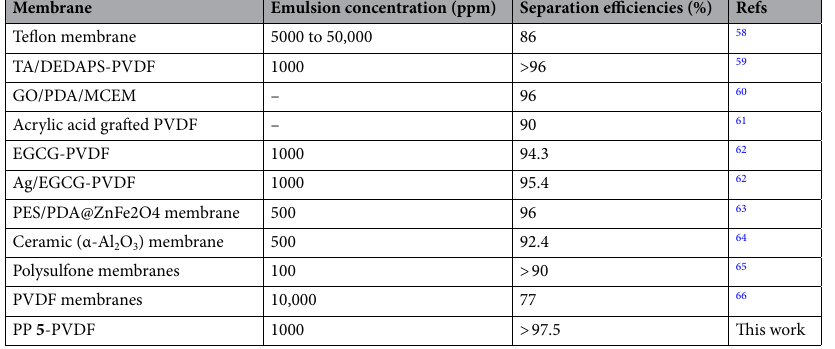
Table 2. Comparison of the PP 5 -PVDF separation performance with various